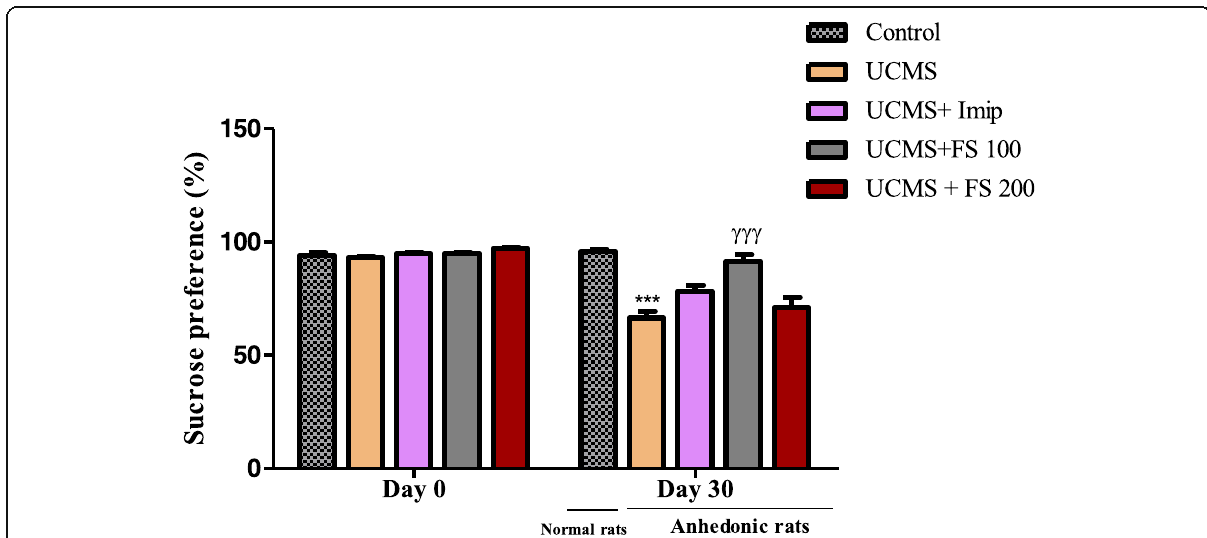
Fig. 6 Percentage of sucrose preference in rats before the UCMS (Day 0) and the effect of hydromethanolic extract of F. sycomorus on anhedonia (Day 30). UCMS: unpredictable chronic mild stress; Imip: imipramine, FS: Ficus sycomorus extract. *** P<0,001 vs. Control; γγγ p <0,001 vs. anhedonic rats treated with